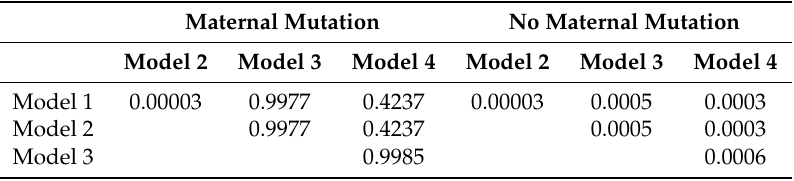
Table 2. Maximal difference of probability of paternity values between i -th and j -th model ( ρ i , j ) in two cases: with maternal mutation and without it, at the D5S818